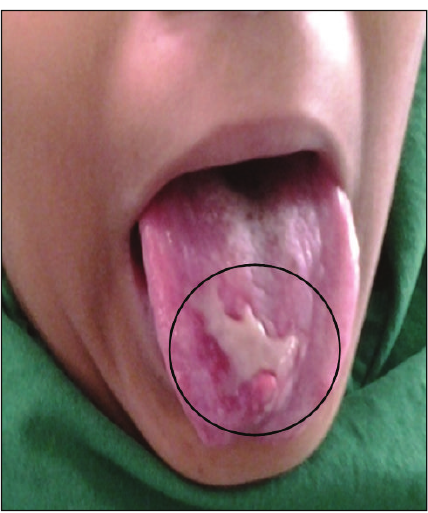
Figure 1: Dorsum of tongue showing ulcerative lesion.